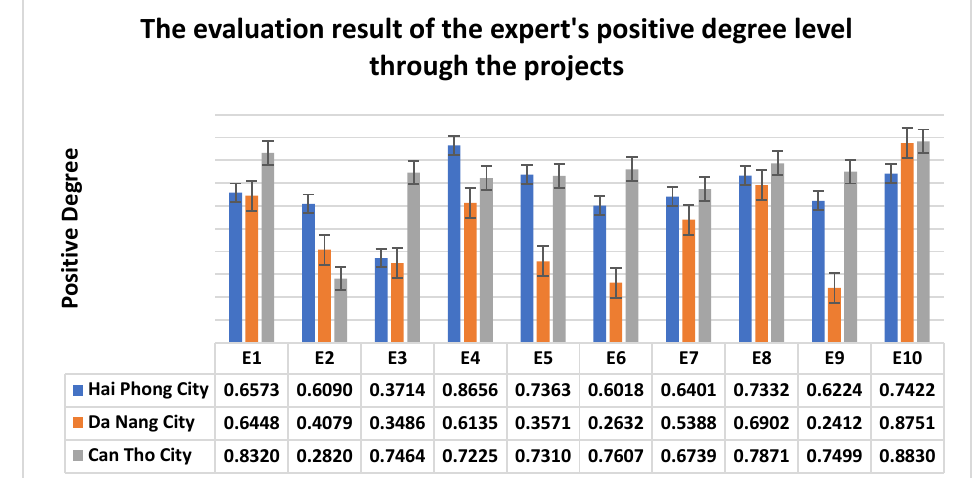
Figure 3. The evaluation result of the expert’s positive degree.